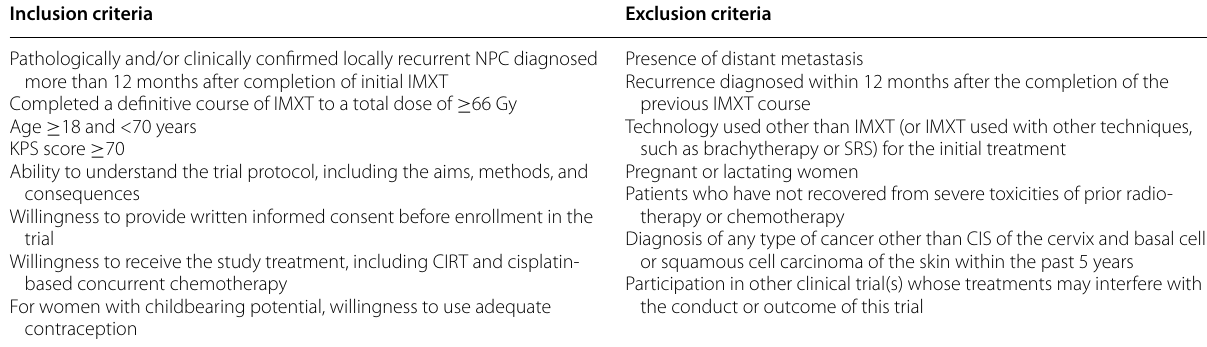
CIRT carbon-ion radiotherapy, IMXT X-ray–based intensity-modulated radiotherapy, KPS Karnofsky performance status, SRS stereotactic radiosurgery, CIS carcinoma in situ